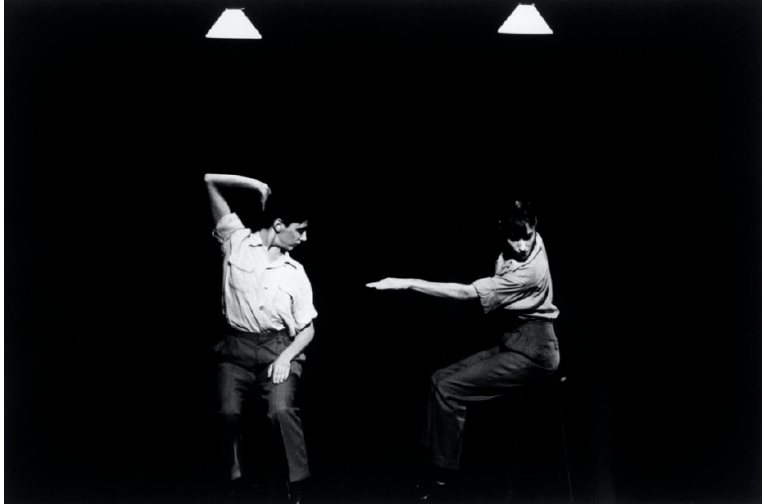
Figure 9. Fase (1982) Anne Teresa De Keersmaeker / Rosas © Herman Sorgeloos. Used with